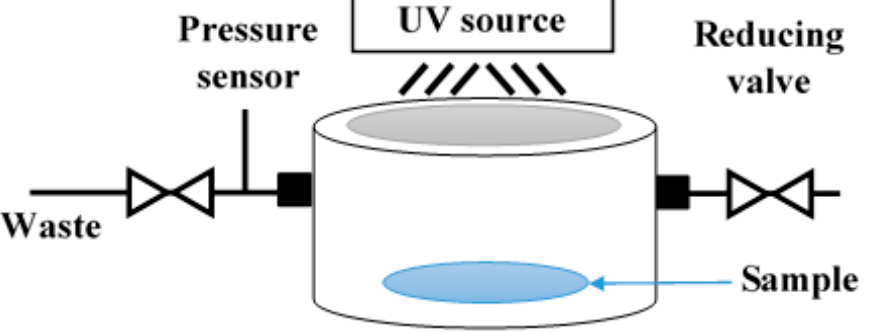
Figure 6. Scheme of the photo-reactor used to decompose N 2 O gas.